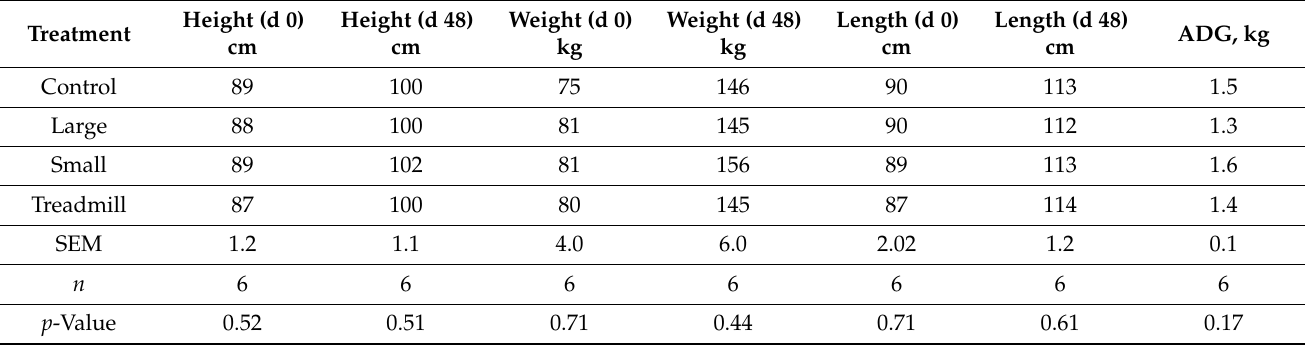
Table 2. Initial (d 0) and final (d 48) calf height, weight, and length by treatment, as well as average daily gain (ADG).